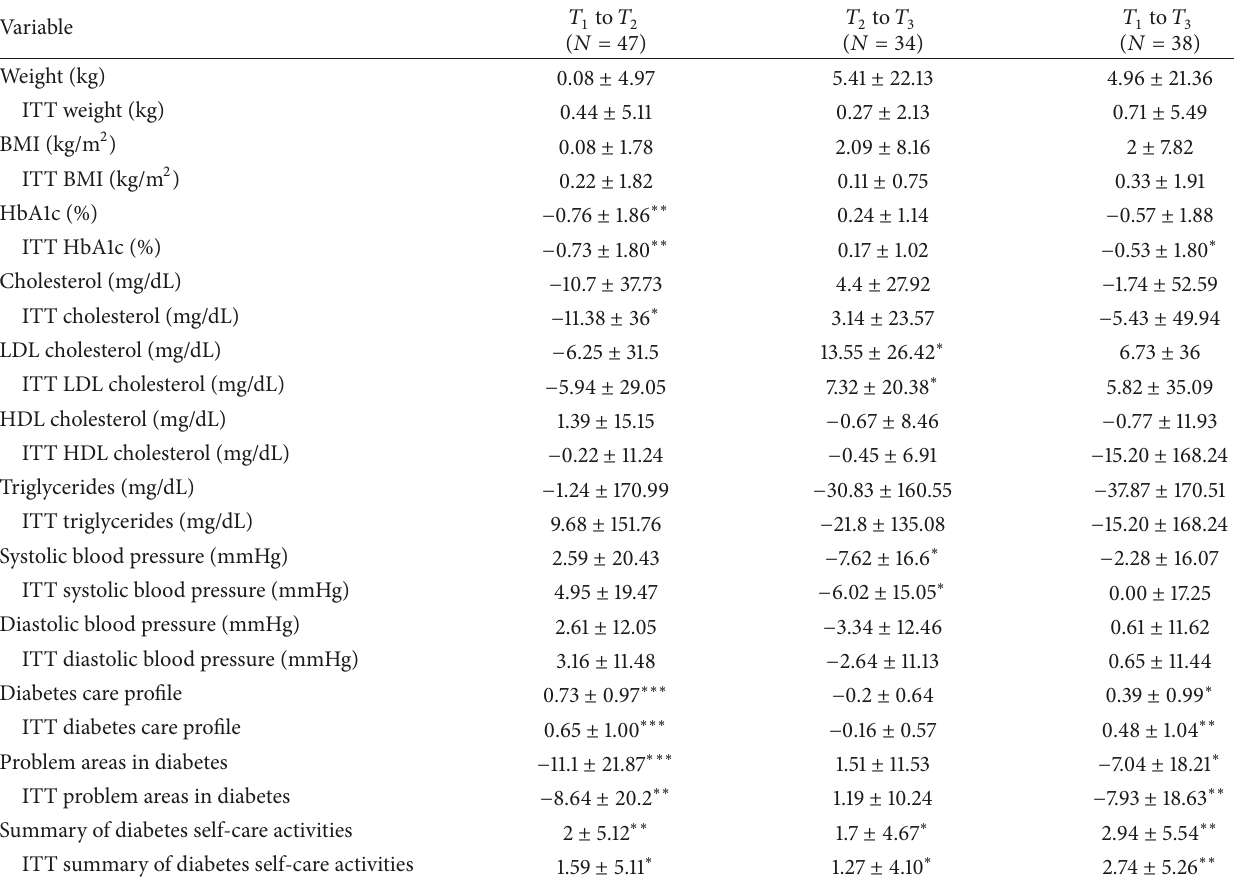
Table 2: Mean change in behavioral and biological measures across three assessments for the combined